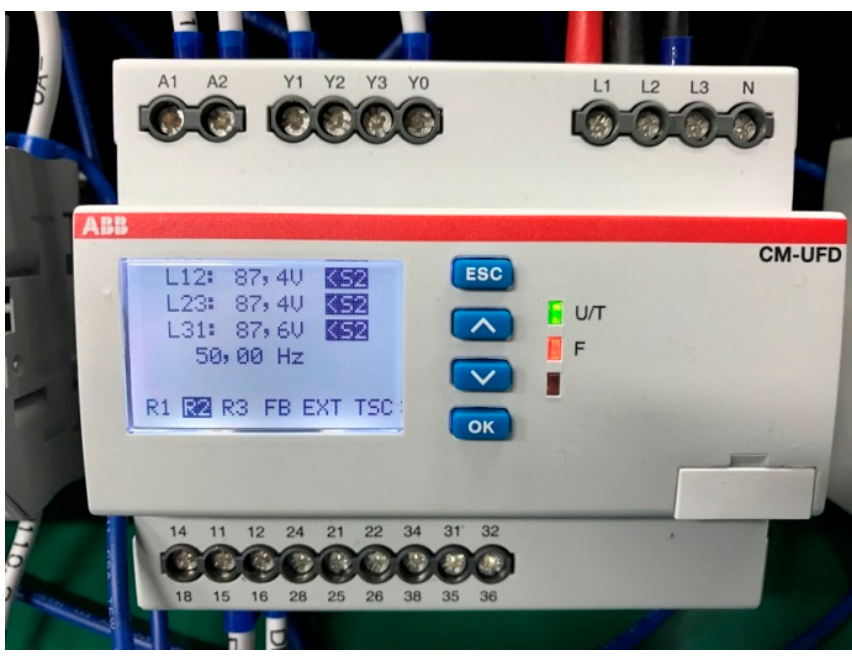
Figure 28. Under voltage relay operation.